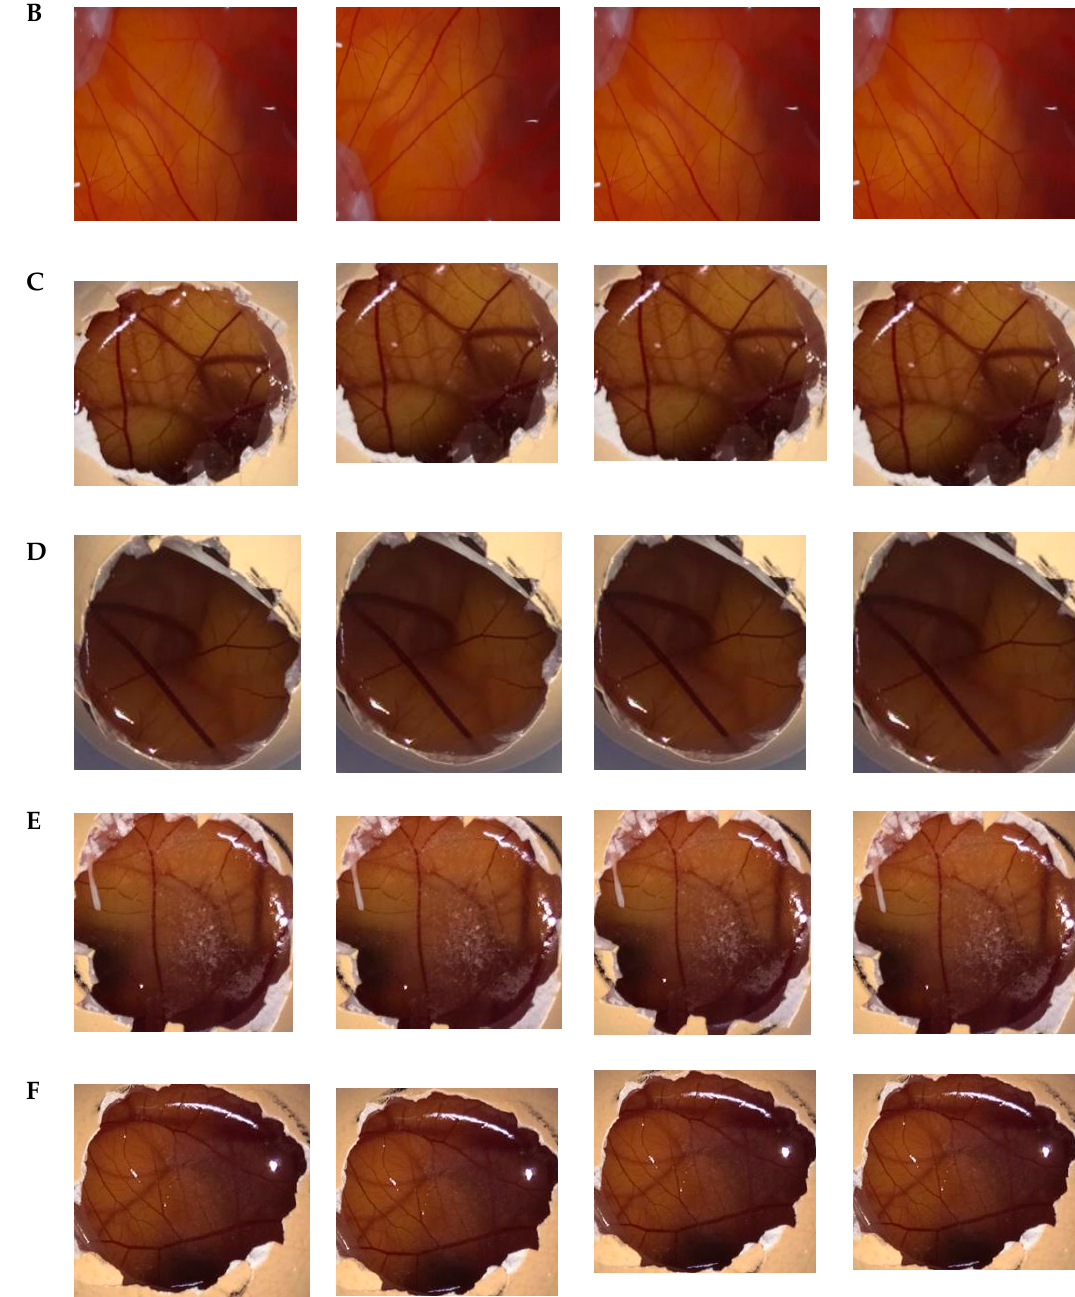
Figure 4. Representative stereomicrographs of Chorioallantoic Membrane (CAM) after application of: ( A ) 0.1 M sodium hydroxide (NaOH) solution, ( B ) 0.9 wt% saline solution, ( C ) polymeric nanocapsules (NCs), ( D ) polymeric nanocapsules loading benzophenone-3 (BZP3-NCs), ( E ) blank semi-solid formulation (without NCs), and ( F ) semi-solid sunscreen formulation (with BZP3-NCs).